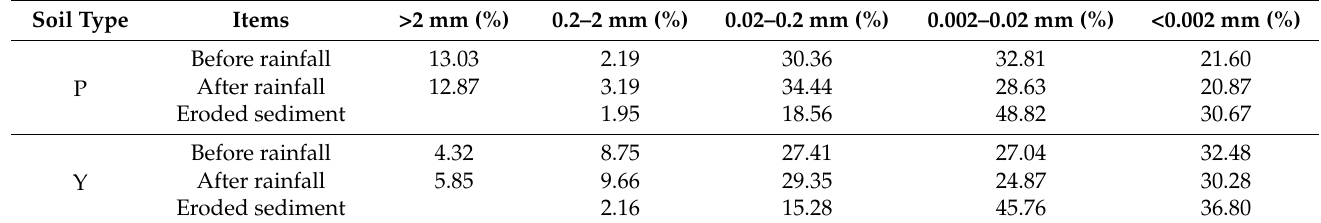
Table 2. Particle size distribution in surface soils before and after rainfall and in eroded sediments at slope 15 ◦ and 3.0 mm min − 1 rainfall